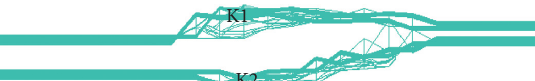
Surface Quaternary boundary Figure 4: Quaternary stratigraphic boundary and surface grid map (front view). K1